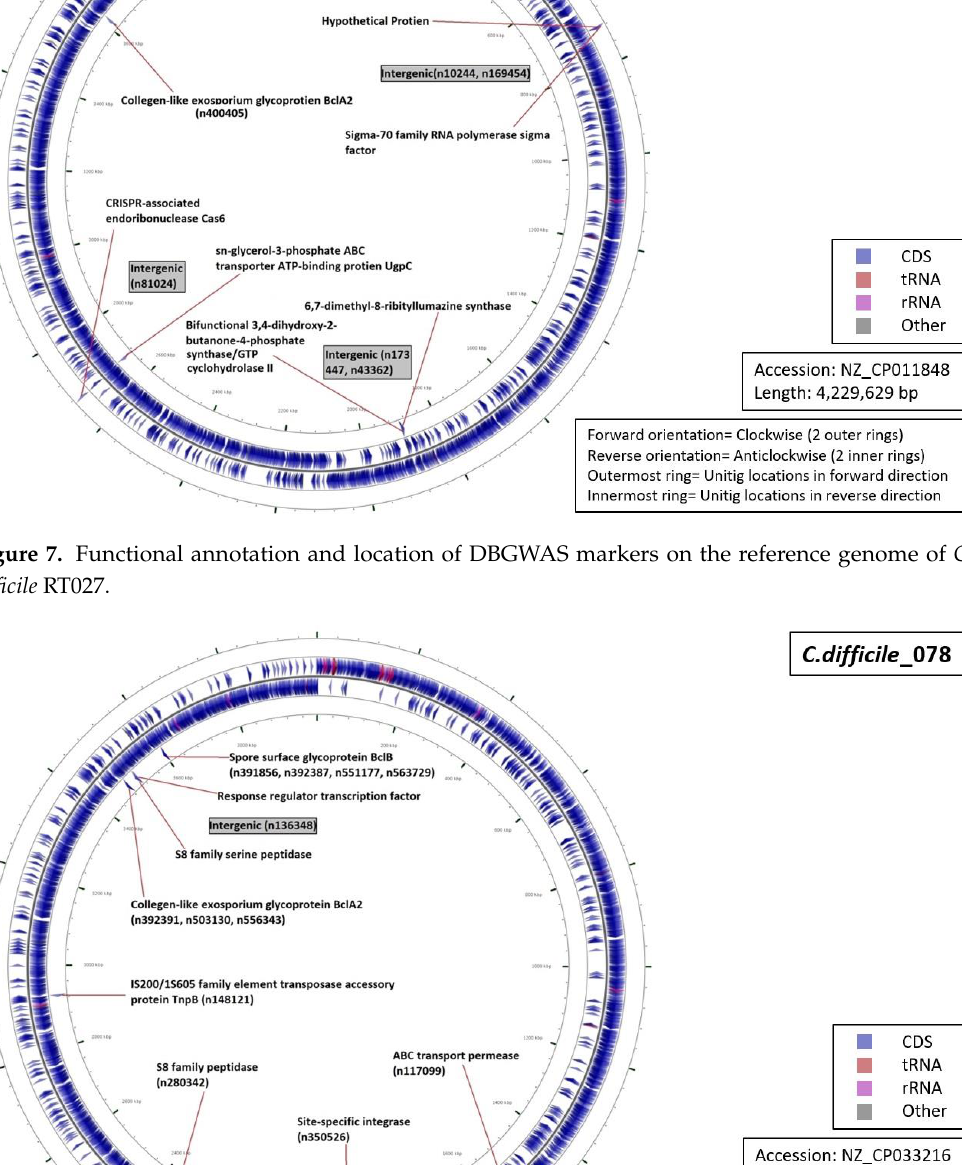
Figure 8. Functional annotation and location of DBGWAS markers on the reference genome of C. difficile RT078.